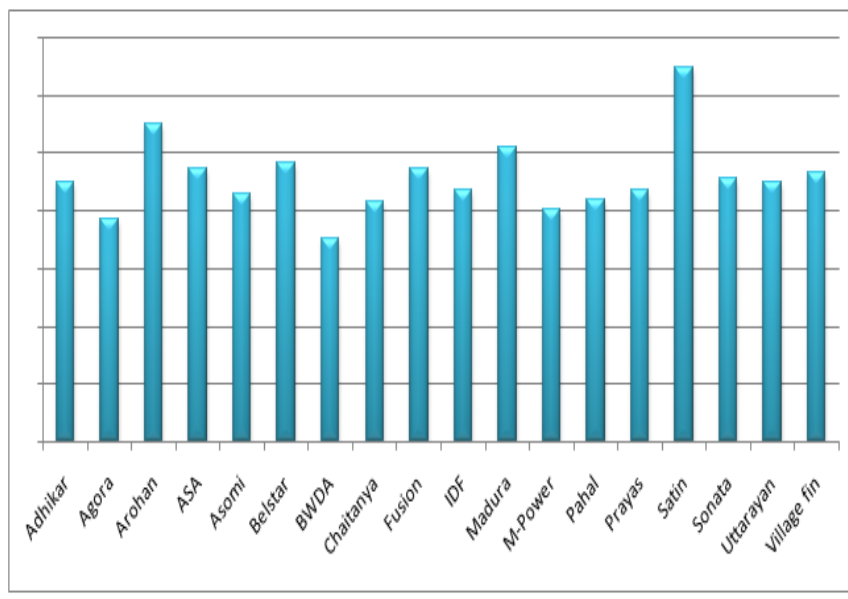
Figure 2. Ranking of NBFC-MFIs from 2014-15 to